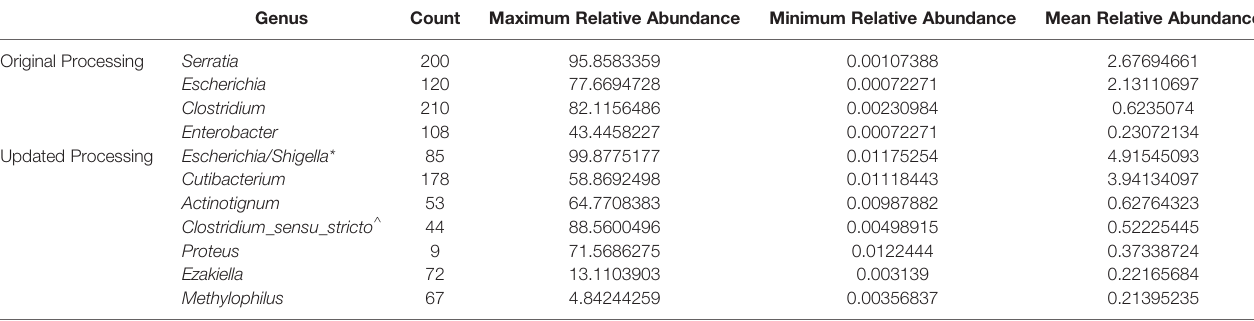
Figure 2 . A higher relative abundance of Lactobacillus was TABLE 2 | Unique taxa with highest mean abundances from original and updated